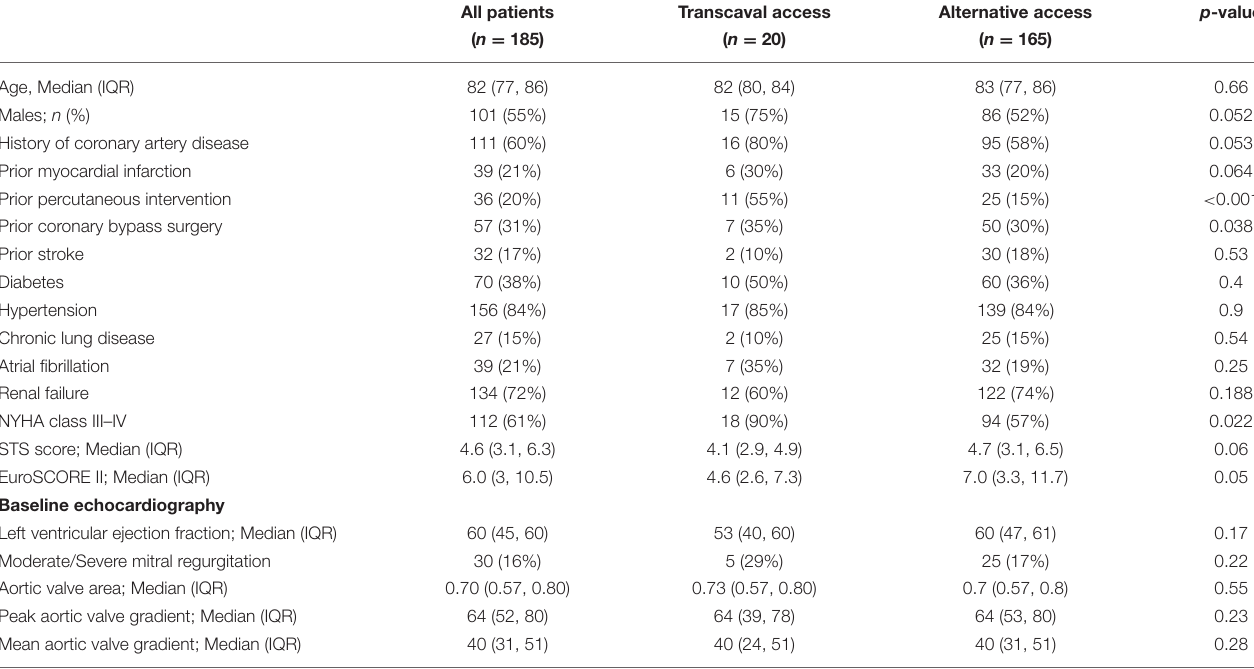
TABLE 1 | Baseline characteristics of patients undergoing TAVR via transcaval vs. alternative access.